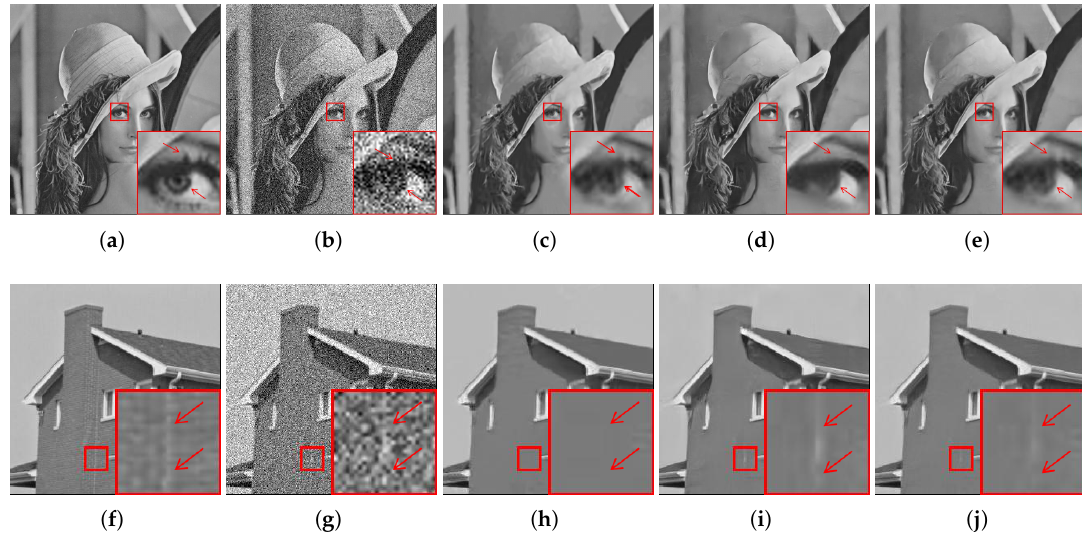
Figure 1. Examples showing the effectiveness of the proposed booster in improving NCSR and DnCNN. ( a ) Original image. ( b ) Noisy image. ( c ) Input image denoised by NCSR, PSNR = 29.11 dB. ( d ) Input image denoised by DnCNN, PSNR = 29.50 dB . ( e ) Our final denoised result, PSNR = 30.04 dB. ( f ) Original image. ( g ) Corrupted image. ( h ) Input image denoised by NCSR, PSNR = 32.13 dB. ( i ) Input image denoised by DnCNN, PSNR = 32.26 dB. ( j ) Our final denoised result, PSNR = 33.29